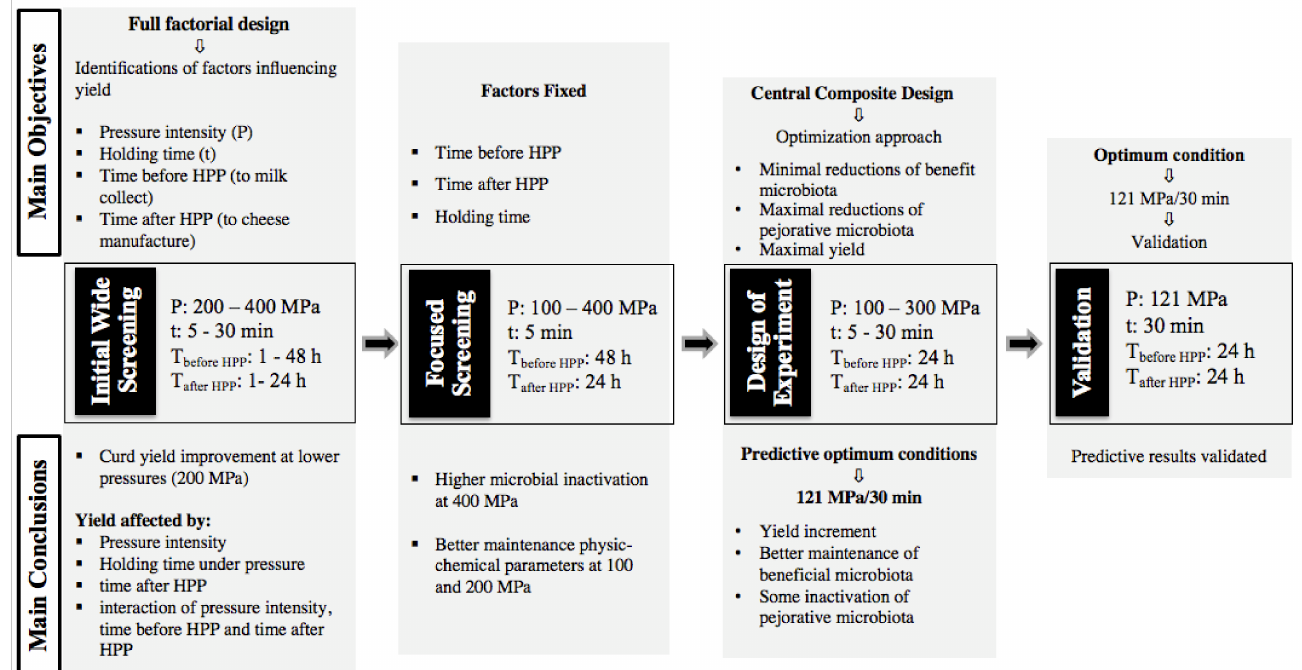
Figure 1. Schematic representation of initial wide screening, focused screening, design of experiment and